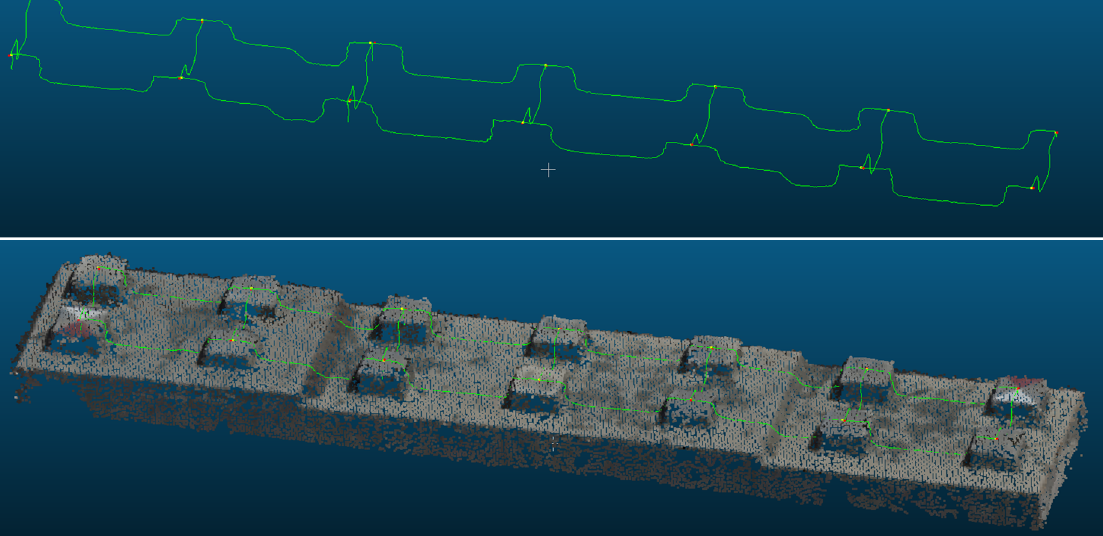
Figure 11. Location of the total station points (red point) and the extracted points according to proposed method (yellow).